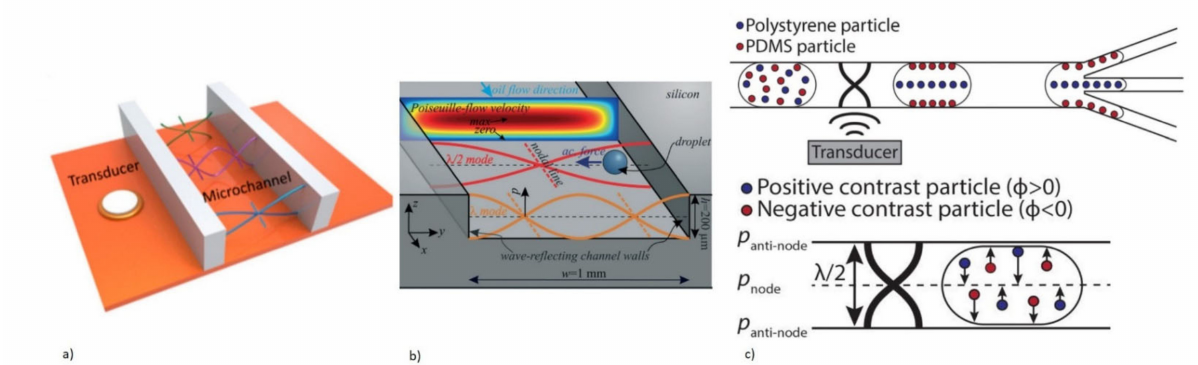
Figure 36. BAW microfluidic devices. ( a ) Basic architecture of a BAW-based microfluidic actuation device with a piezoelectric transducer and microchannel. Generated bulk acoustic waves produce standing waves inside the channel which serves as a resonator [321]. Reproduced with permission from Y. Gao et al., Micromachines; published by MDPI, 2020 (open access) ( b ) Schematic of standing waves with pressure nodes and antinodes inside the channel. ARF attracts the particles towards pressure nodes and antinodes depending on the phase factor. Reproduced with permission from Ivo Leibacher et al. [333], copyright 2015, The Royal Society of Chemistry; published by Lab Chip, Creative Commons (open access). ( c ) BAW-based microfluidic separation of particles based on particle physical property [335]. Reproduced with permission from Anna Fornell et al., Applied Physics Letters; published by AIP Publishing,